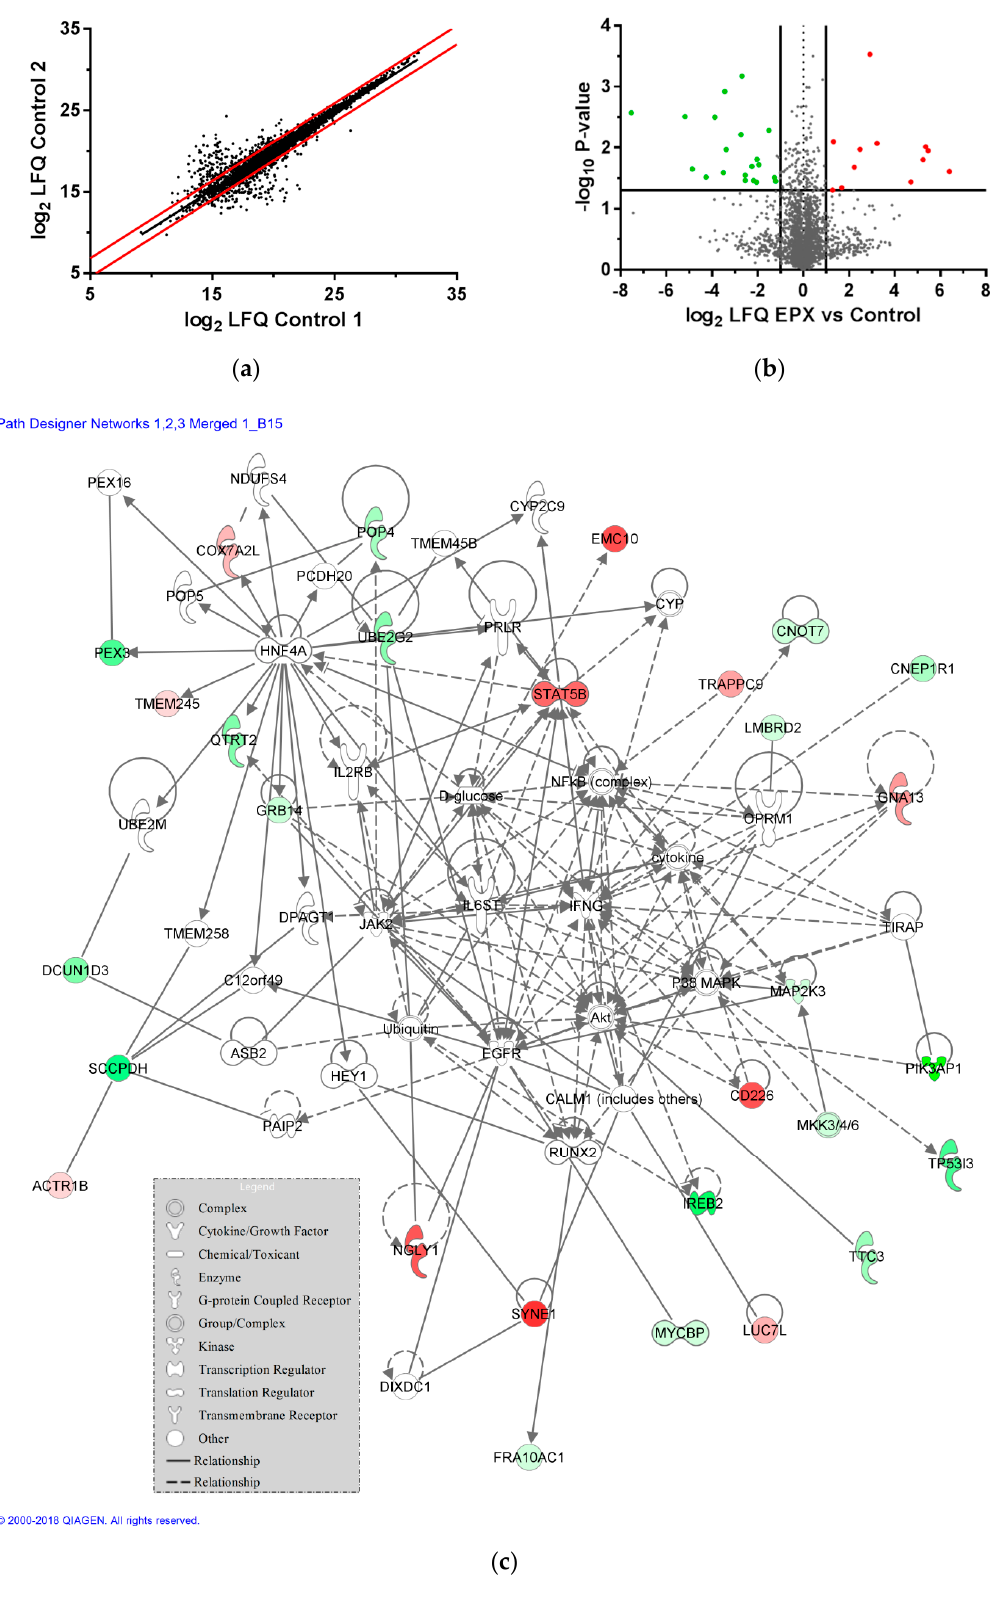
Figure 6. Mass spectrometric analysis of the proteome of LCL721.221 cells expressing sB*15:02: ( a ) LFQ intensities spread of the proteome for untreated recombinant B-LCL cells transduced with sHLA-B*15:02. Protein intensity ratios of LC-MS analyzed untreated control replicates, depicted as log2-values, were plotted against each other. Regulation limits were determined through 95% confidence range (red lines) and set to log2 ± 1.1; ( b ) Protein abundance after EPX treatment. Results are shown